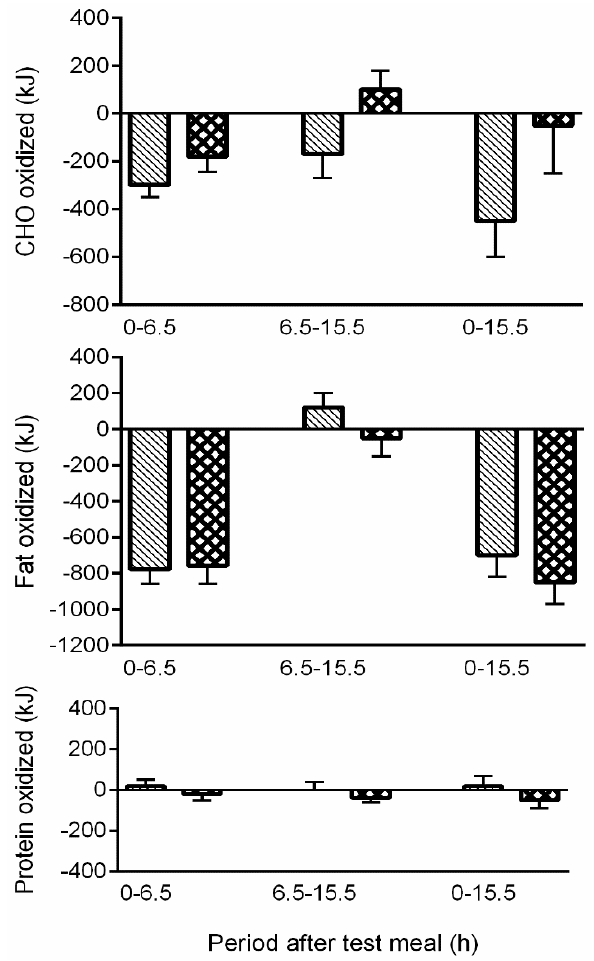
Figure 1. Change in macronutrient oxidation over 15.5 h in response to addition (ADD) or substitution (SUB) of alcohol into a test meal, relative to a no alcohol control. SUB ( ▧ ), 50en% from CHO substituted for alcohol; ADD ( ▩ ), 50en% from CHO added as alcohol .